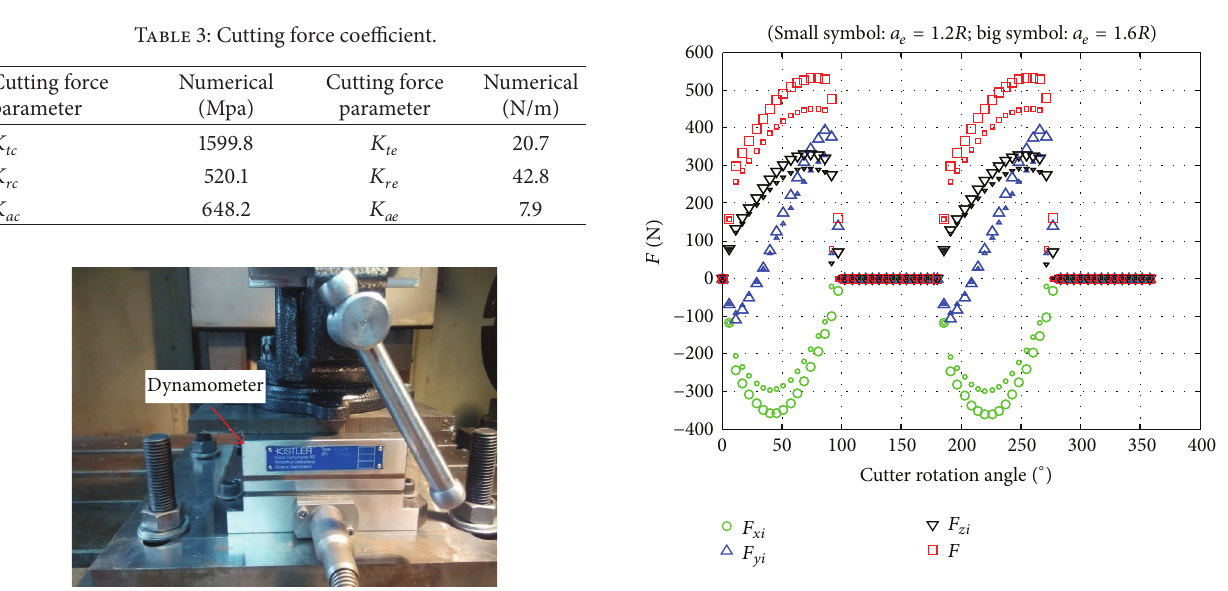
Figure 10: Effect of cutting width 𝑎 𝑒 on cutting